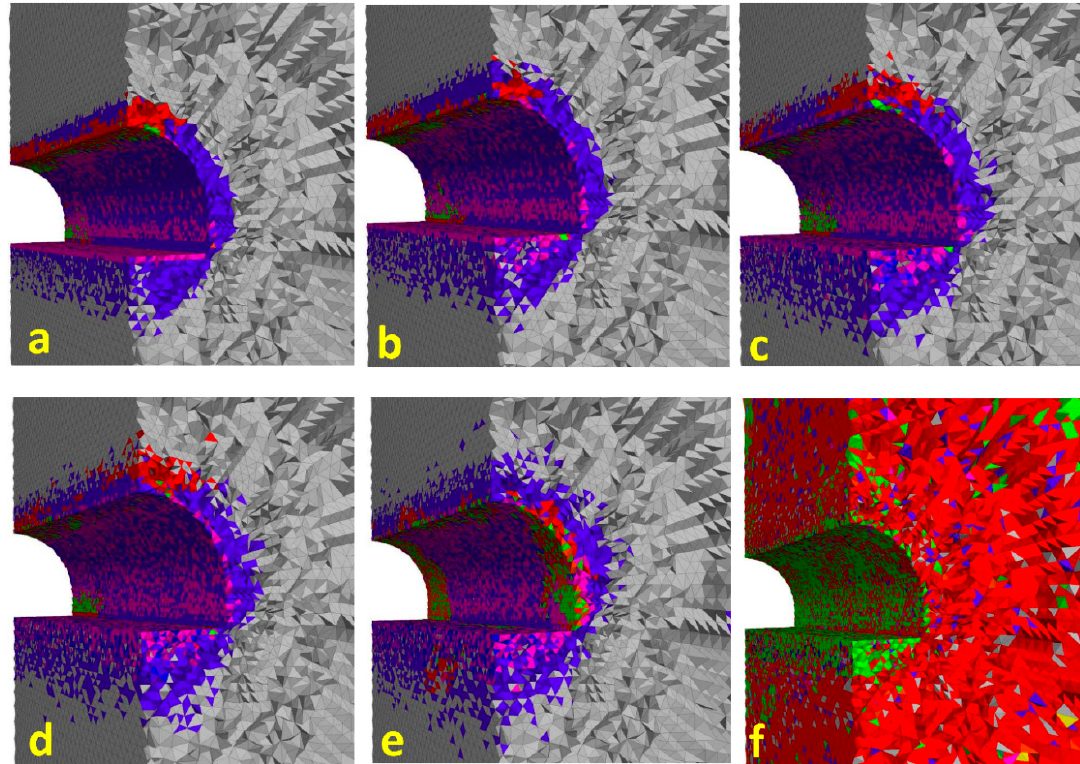
Figure 9. Plasticization zones in the model with the distribution of strength and deformation parameters, variability coefficients: ( a ) 5%, ( b ) 10%, ( c ) 15%, ( d ) 20%, ( e ) 25%, ( f ) 30%.